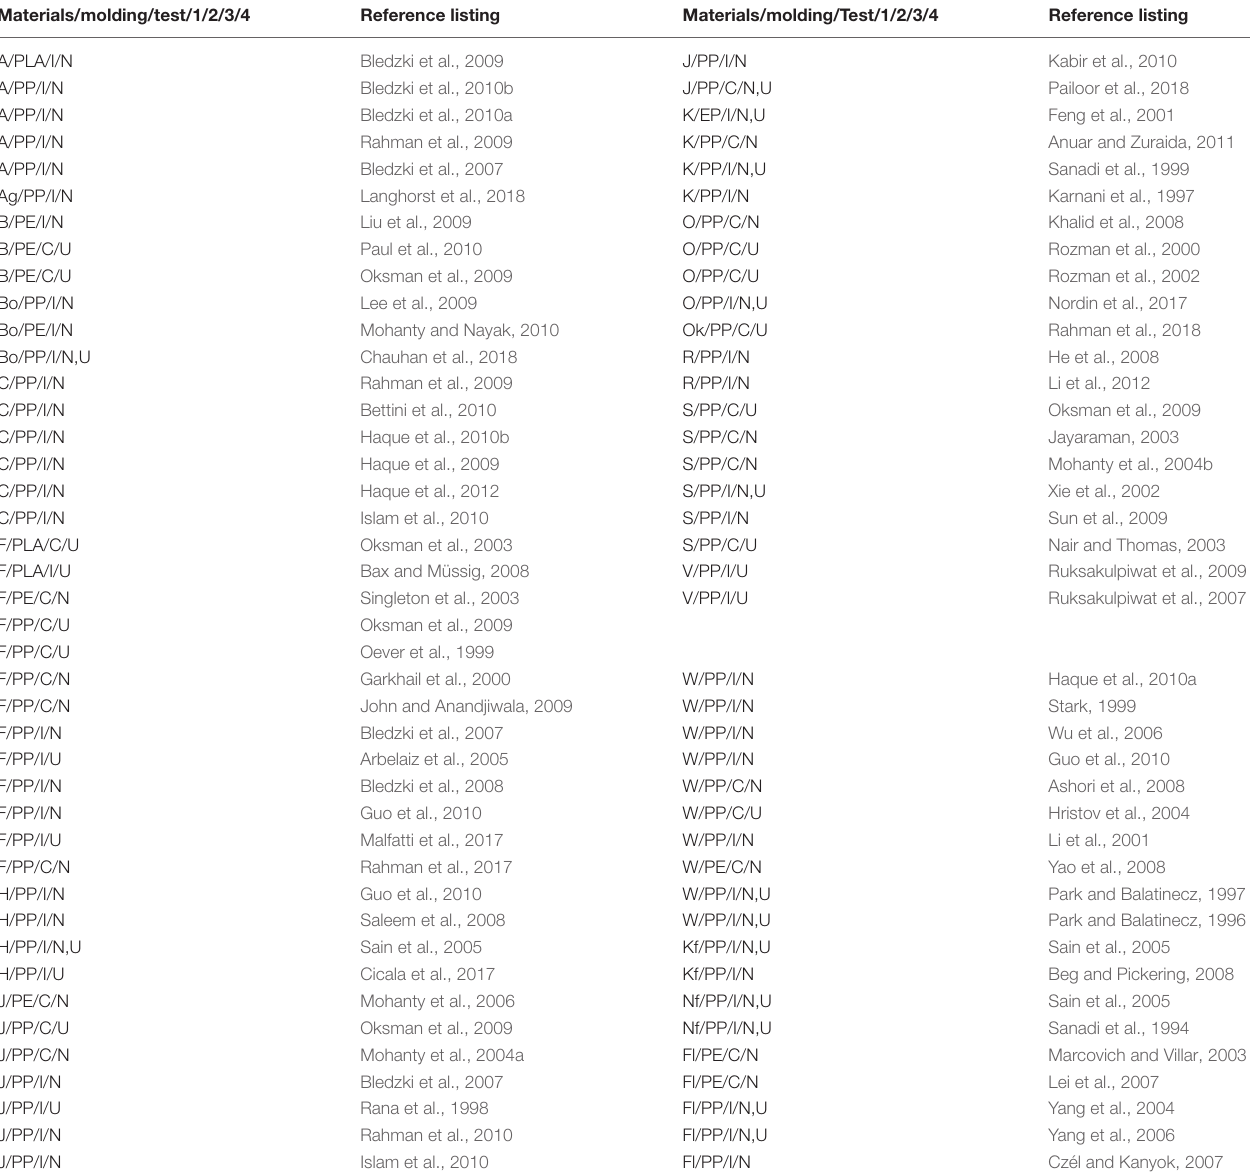
TABLE 2 | Overview of the papers discussed in this review ordered by fiber type, polymer type, molding process, and impact